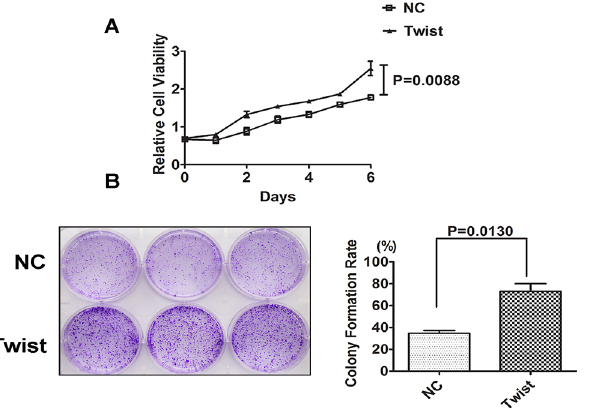
Fig 3. Overexpression of Twist in MCF-7 promotes proliferation and cloney formation ability. (A) Overexpression of Twist enhanced the proliferation of MCF-7 cells. CCK8 assays were used to estimate the cell proliferation at different time points. Data shown are means ± SD of at least three independent experiments. P-values were obtained using the Student ’ s t-test analysis. (B) Representative colony formation assay with monolayer culture to assess the tumorigenesis function of Twist. Twist-negative MCF-7 breast cancer cell were then co-transfected with pFlag-Twist and pcDNA3.1-luc2.The cell were co-transfected with pFlag-CMV and pcDNA3.1-luc2 as negative control. Twist greatly increases the colony formation of tumor cells. Quantitative analyses of colony numbers and the clony formation rate were from three independent